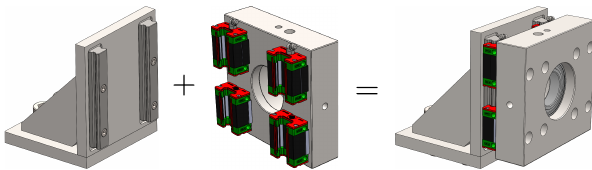
Figure 10: Bracket with linear rolling element bearings connected to the test bearing housing.